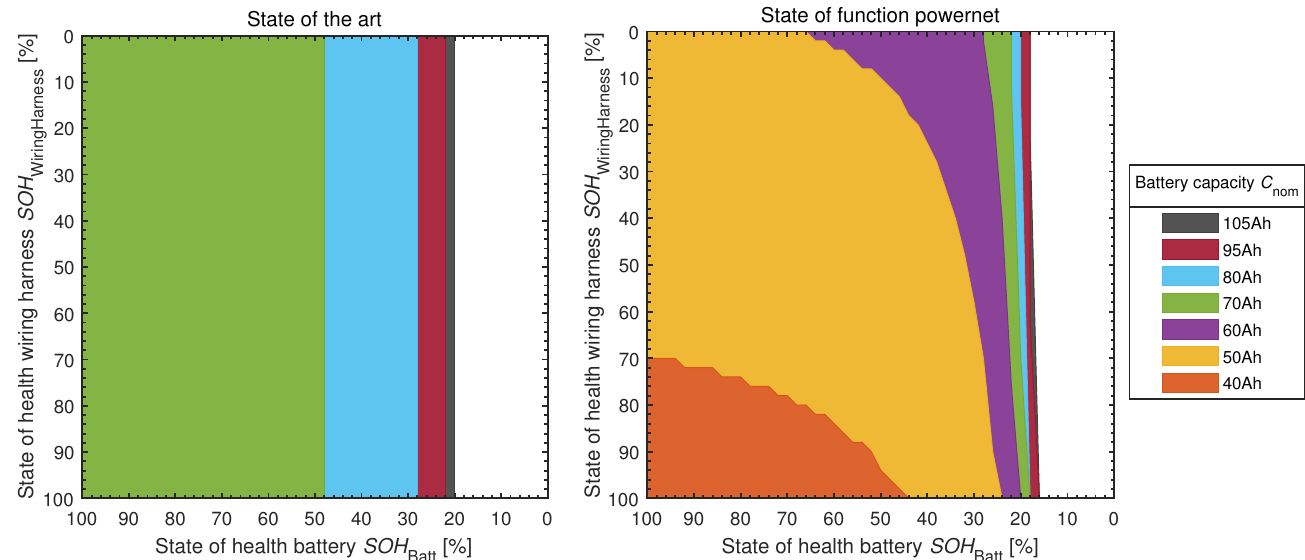
Figure 12. Comparison of different nominal battery capacities between state of the art and the SOFPN, considering battery and wiring harness